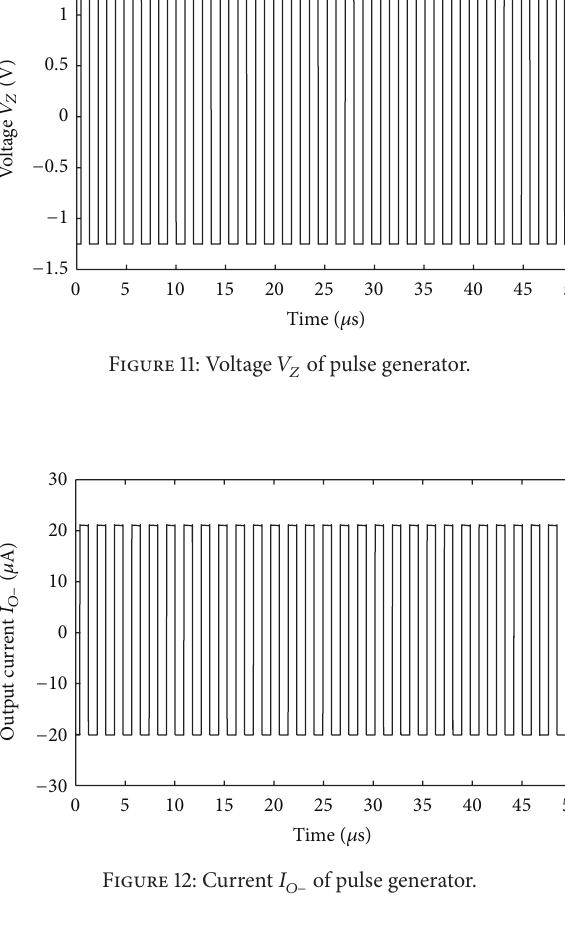
= 𝐼 = 20 𝜇 A, (b) 𝐼 = Bias 1 Bias 2 Bias 1 = 𝐼 = 40 𝜇 A, and (d) 𝐼 = 𝐼 = 50 𝜇 A. Bias 1 Bias 2 Bias 1 Bias 2